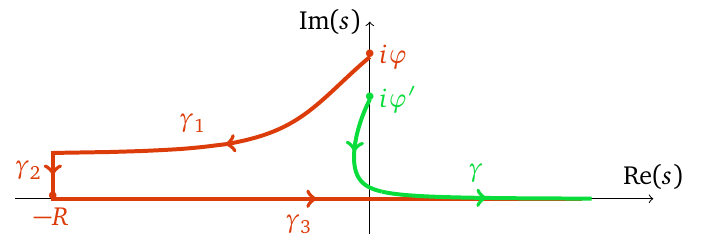
, the path (red) c , γ , γ , where γ and γ are steepest descents while γ is 1 2 3 1 3 2